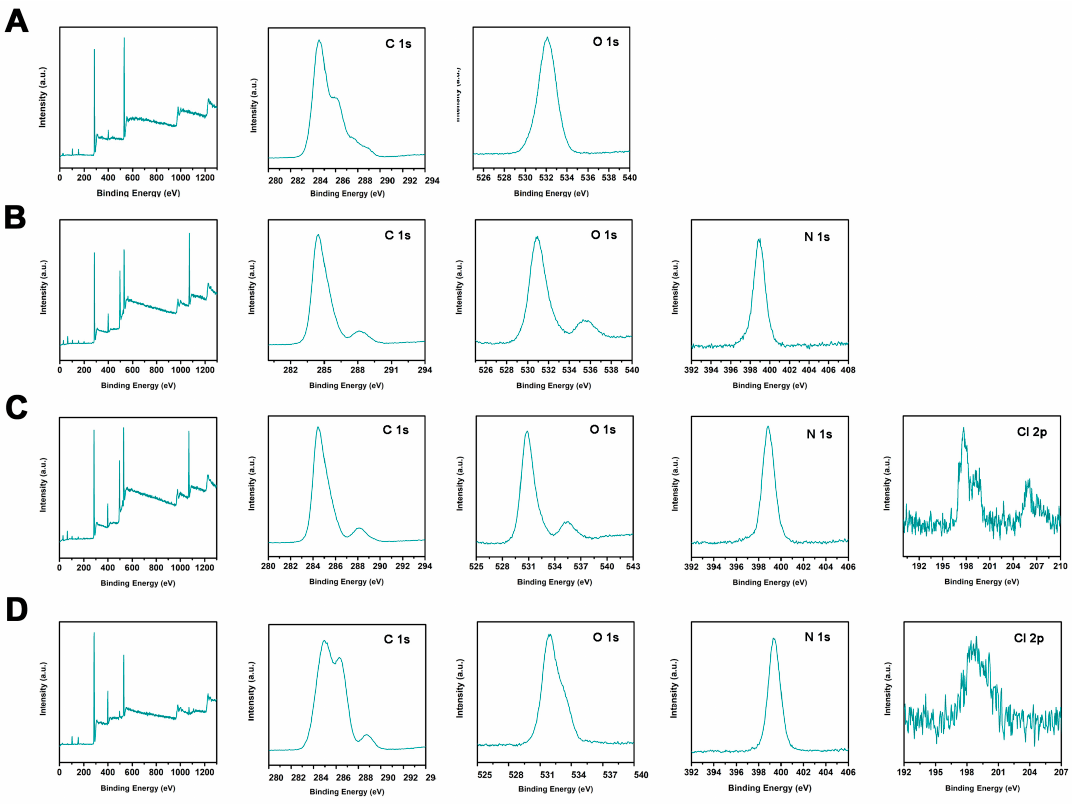
Figure 4. XPS survey scans: C 1s spectrum, O 1s spectrum, N 1s spectrum, and Cl 2p spectrum of ( A ) SG, ( B ) aSG, ( C ) cSG, and ( D ) cSG-PAN.